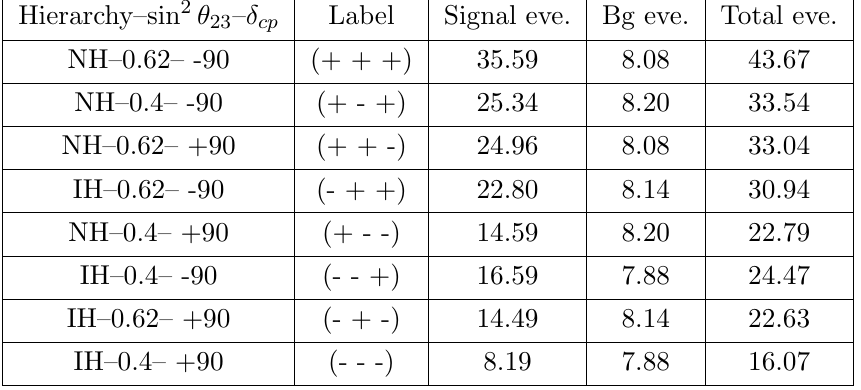
Table 3 . Number of (cid:23) e appearance events for one year (cid:23) run of NO (cid:23) A, for the eight di(cid:11)erent combinations of unknowns. Hierarchy{sin 2 (cid:18) { (cid:14) Label Signal eve. Bg eve. Total eve. 23 cp